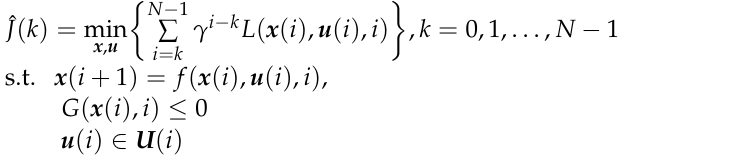
discount factor.